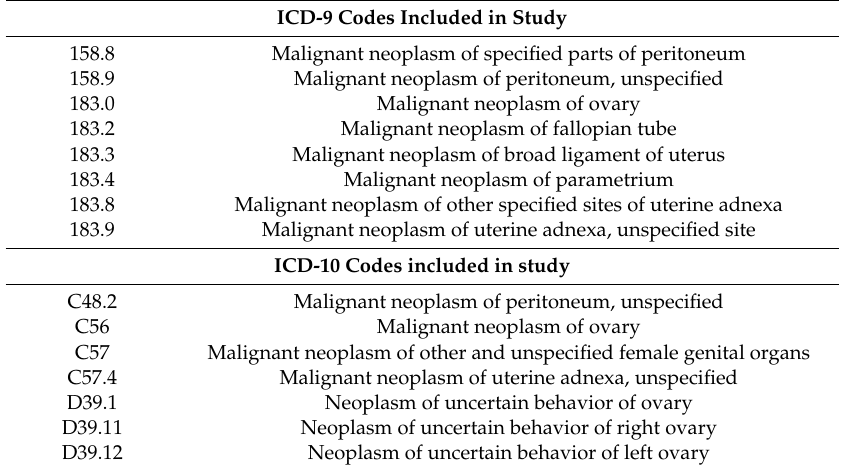
Table A2. International statistical classification of diseases and related health problems codes included in the